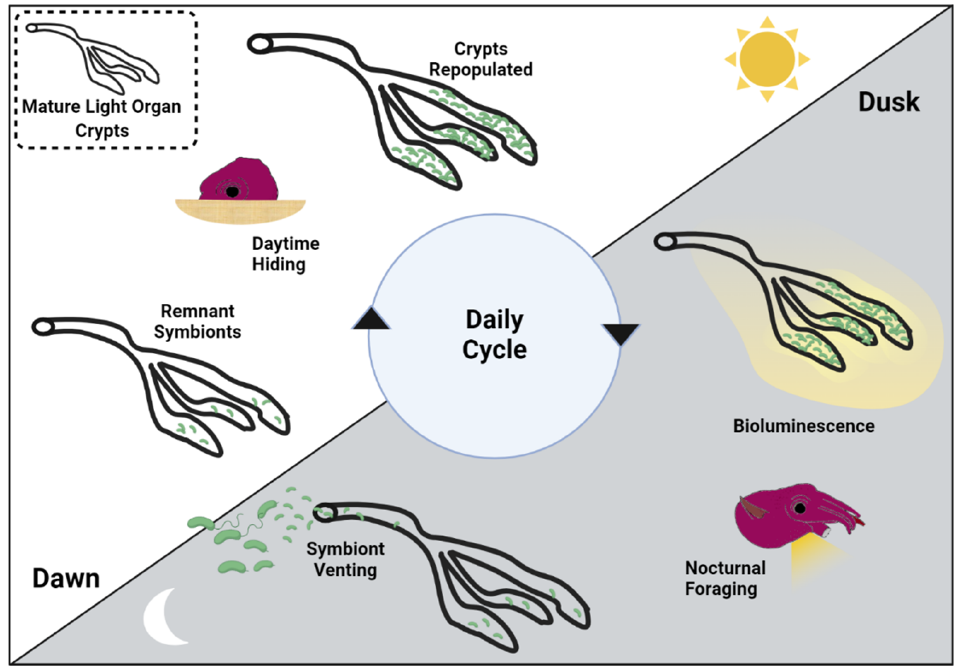
Figure 1. Nocturnal bioluminescence production in the mature light organ. Four weeks after initial symbiont colonization of the light organ a mature diel cycle has developed that will last the life of the squid host. At dawn, 90–95% of the light organ symbionts are vented into the seawater column, where they adopt a planktonic lifestyle until they colonize a newly hatched squid. As the host squid buries itself under the sand and rests during the day, the remaining symbionts rapidly repopulate the light organ. Though high cell densities are reached within a few hours, bioluminescence is not triggered until dusk, when the squid emerges from the sand to forage. At dawn, with bioluminescence no longer needed, most of the symbionts are vented, and the cycle repeats.